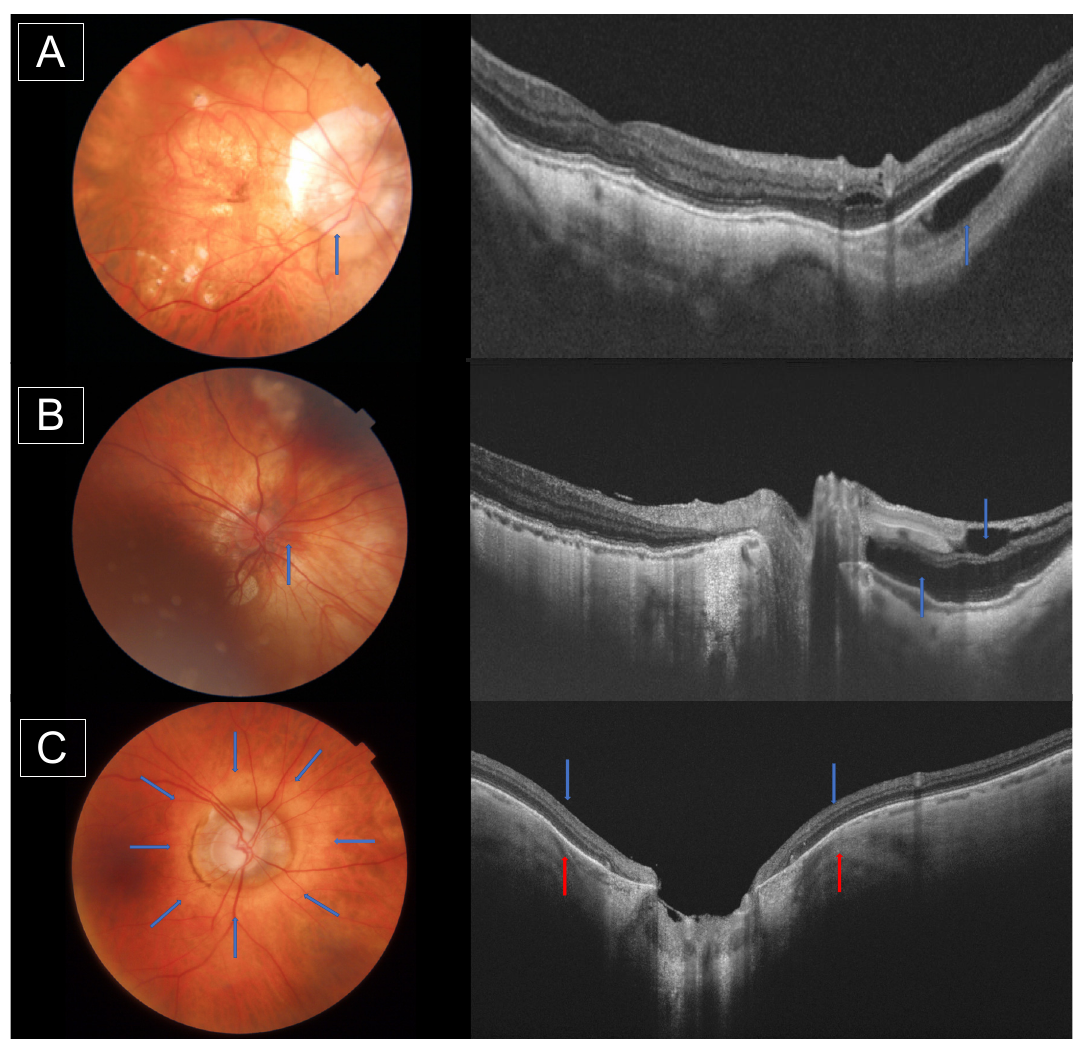
Figure 3. Fundus photography and optical coherence tomography (OCT) of the peripapillary region of a myopic subject. ( A ): Blue arrow represents peripapillary intrachoroidal cavitation observed in the photography as a yellowish peripapillary lesion and in the OCT image as a hyporeflective triangular thickening of the choroid with the base at the optic disc border, ( B ): Blue arrow represents peripapillary retinoschisis observed in the OCT image as cystoid hyporeflective spaces in the peripapillary region around retinal vessels, ( C ): Fundus photography and OCT image of peripapillary staphyloma, blue arrows showing the border of the staphyloma with arched posterior sclera and red arrows showing the thinned choroid at the edge of the staphyloma.